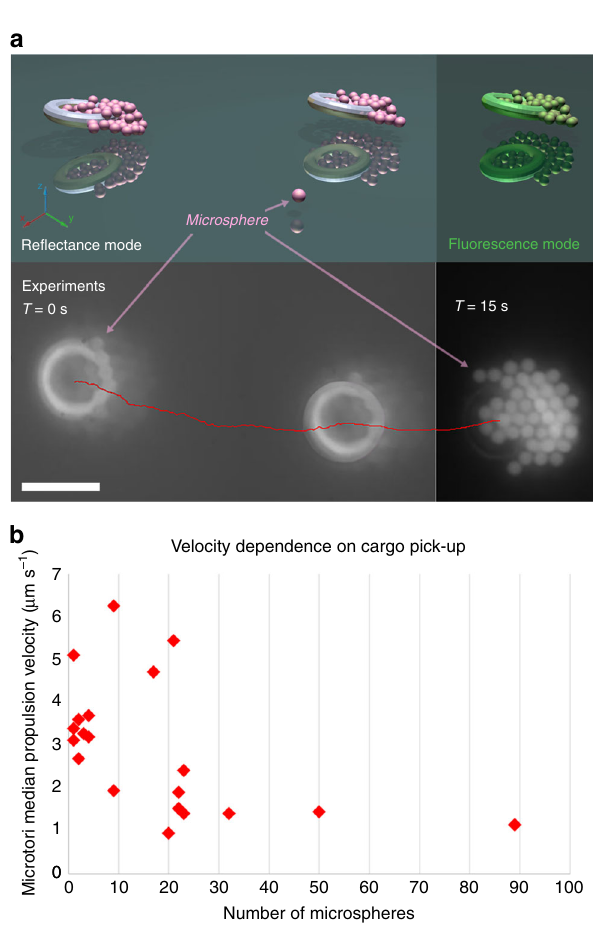
Fig. 5 Passive cargo transport by swimming tori. a A time lapse sequence of a Janus donuts accumulating 1 μ m sulfated polystyrene microspheres along the anode. The microspheres formed a hexagonal close-packed cluster around the inner and outer radii. The scale bar is 6.5 μ m. b The propulsion